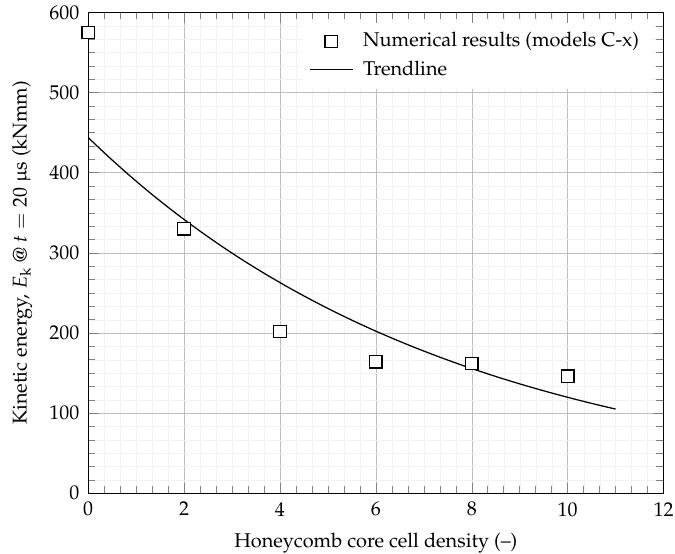
Figure 13. Kinetic energy of the debris particle at t = 20 µ s against the number of cells across the width of honeycomb core.